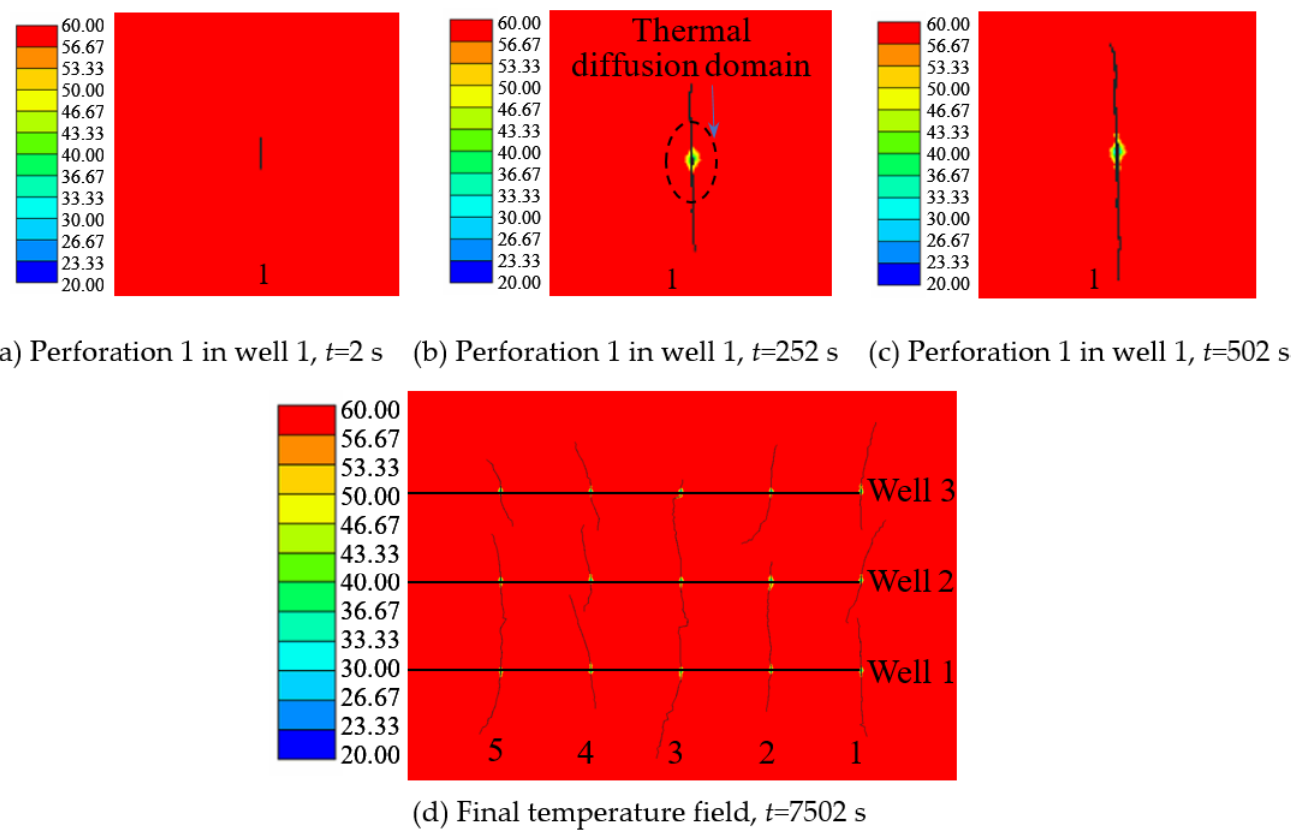
Figure 6. Temperature evolution around hydraulic fractures in multi-well hydrofracturing.